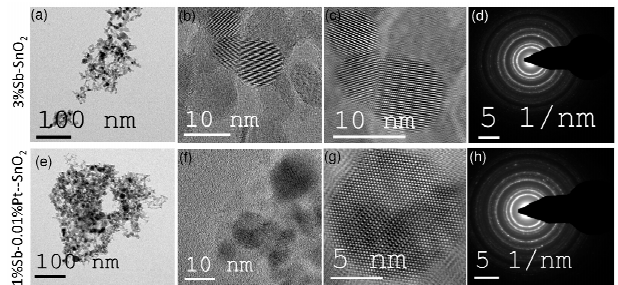
Figure 2. Low-resolution, high-resolution, Fourier-transformed image, and selected area diffraction pattern of 3 wt % Pd-SnO 2 ( a – d ); and 1 wt % Sb–0.01 wt % Pt-SnO 2 sensing materials ( e – h ).